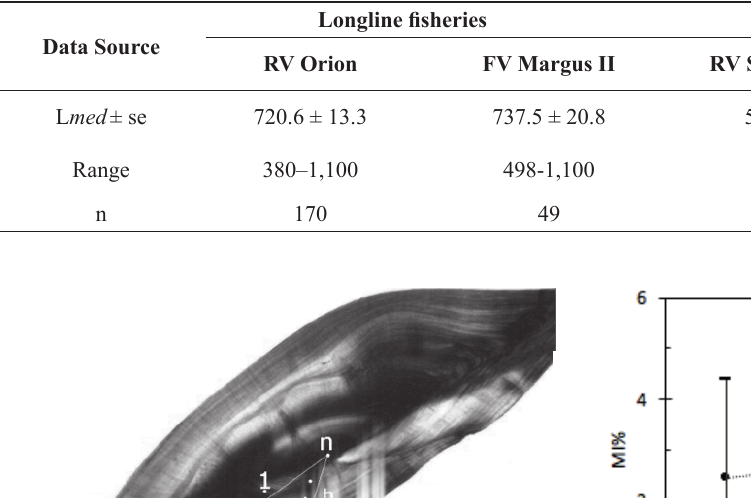
± se) in mm, range and sampled number of the pink cusk eel Genypterus brasiliensis Average length standard errors ( L med for distinct sample sources.